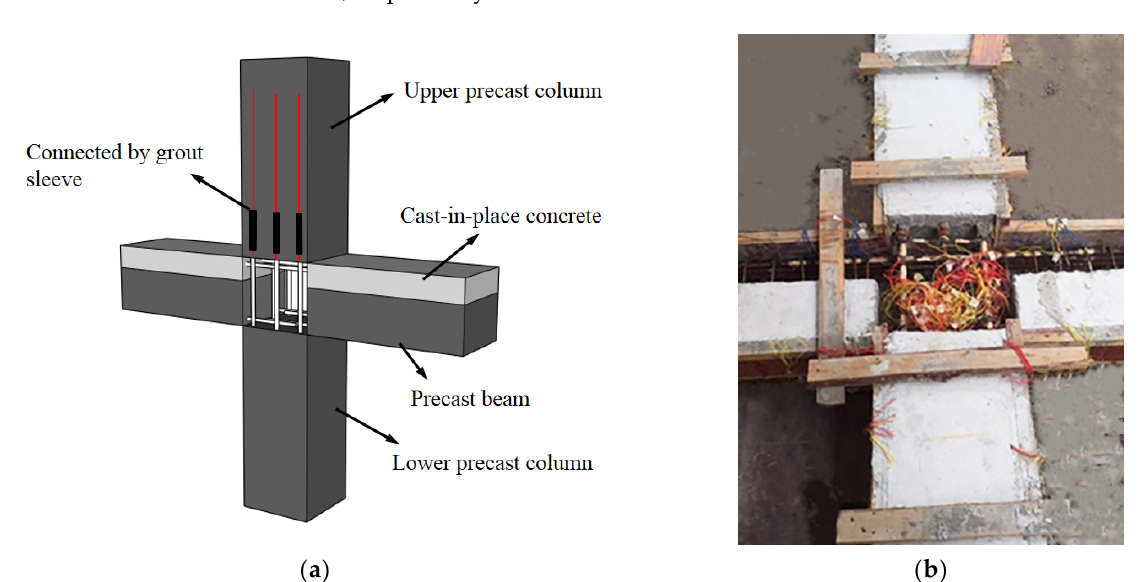
Figure 2. The fabrication of the precast joint. ( a ) Schematic diagram; ( b ) Photo.